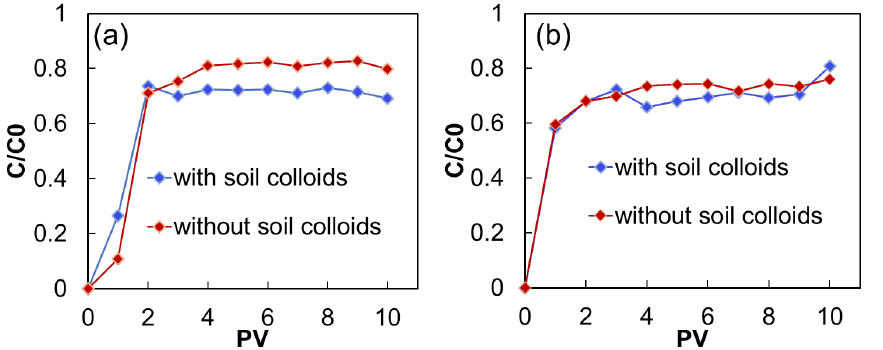
Figure 5. The effect of soil colloids on Ni 2+ transport in the sand column. ( a ) IS = 0; ( b ) IS = 3 mmol·L −1 . The initial concentration of Ni 2+ was 0.6628 mg·L −1 , the different ISs were adjusted with NaNO 3 , the concentration of soil colloids was 220 mg·L −1